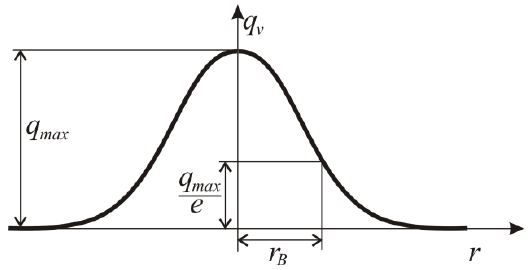
Figure 3. Gaussian surface distribution of the heat